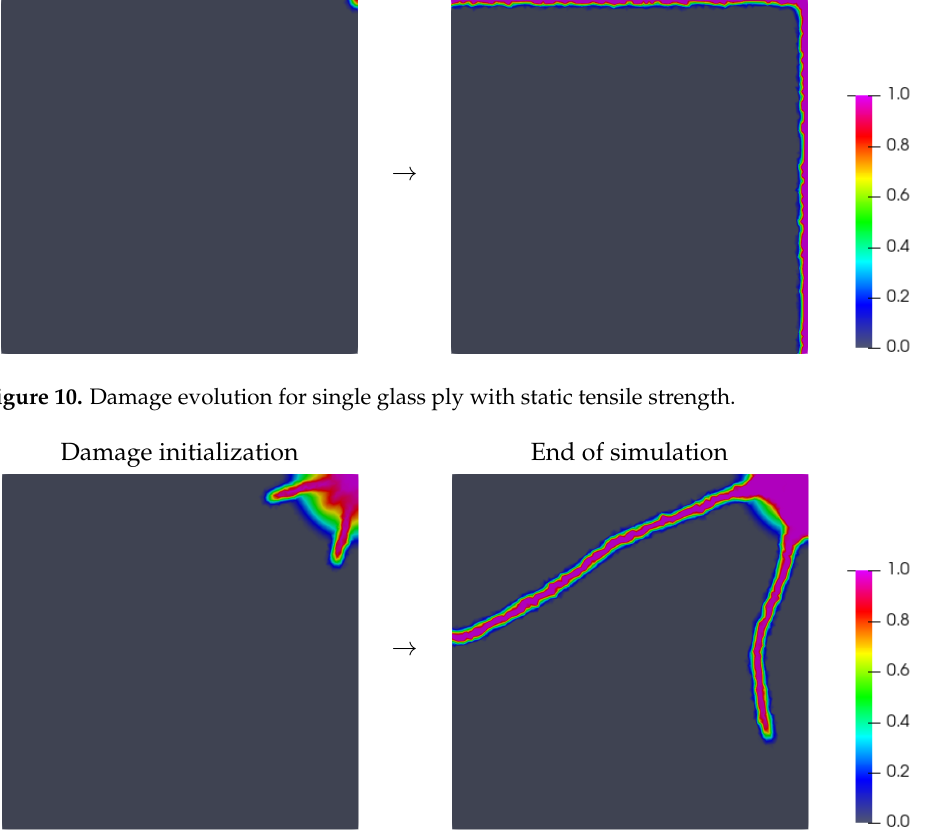
Figure 11. Damage evolution for single glass ply with adjusted initial tensile strength. Figure 9a indicates that assuming the actual static tensile strength f in promotes the damage initiation too early in comparison to the experimental results,